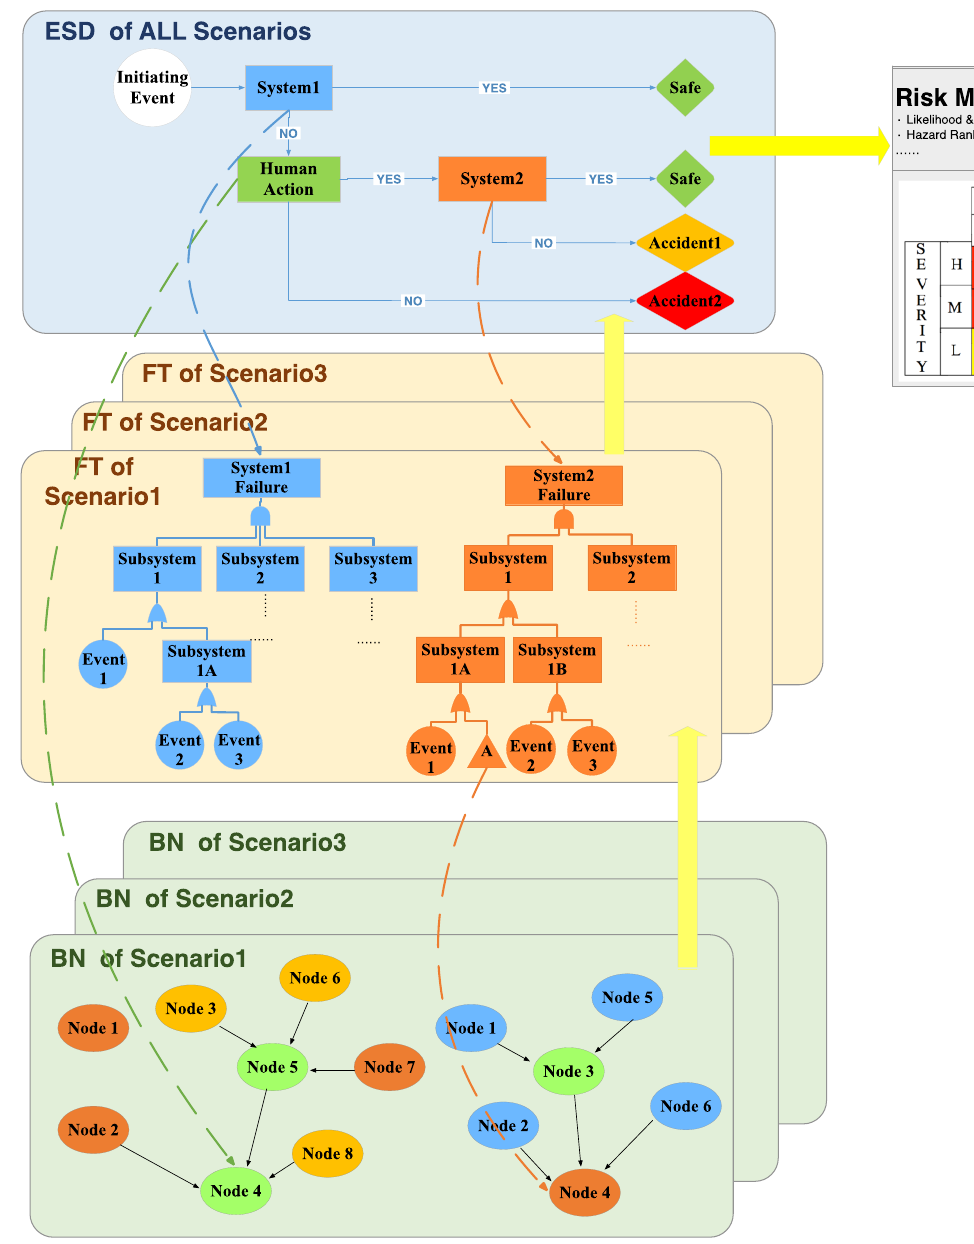
Figure 1. The Structure of the HCL model.